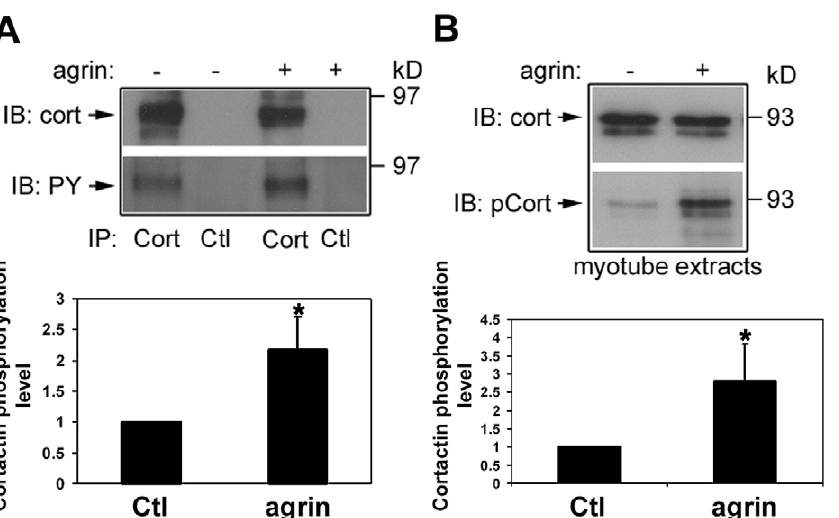
Figure 4. Agrin-dependent enhancement of cortactin tyrosine phosphorylation. Cultured C2 mouse myotubes were exposed to medium without (-) or with added agrin ( + ) before preparing extracts for immuno-precipitation (A) with a monoclonal antibody against cortactin (IP: cort) or an unrelated protein (IP: ctl). When these samples were immuno-blotted for cortactin (IB: cort) and total phosphotyrosine (IB: PY; mAb4G10), cortactin was found to be captured only by the anti-cortactin antibody (upper lanes), and anti-phosphotyrosine staining showed that cortactin from extracts of agrin-treated cells was tyrosine phosphorylated significantly more than that captured from control extracts (lower lanes). This increase in cortactin phosphorylation was quantified from four experiments (A, graph) by measuring band densities, normalizing for cortactin loading (see Methods), and calculating the phosphotyrosine level change relative to control. B. To test whether the src-target sites in cortactin were phosphorylated in response to agrin-treatment, myotube extracts were blotted with antibodies against total cortactin and cortactin phosphorylated on Y421. Agrin-treatment did not alter the amount of cortactin present in extracts (upper lanes) but the staining of cortactin by the anti-Y421-phospho-cortactin antibody (IB: pCort) was enhanced by agrin-treatment more than two-fold, as shown by quantification from three experiments (B, graph). Positions of pre-stained MW markers (Bio-Rad) are indicated on the right side of blots, and in the graphs * represents P , 0.02 in t-tests.